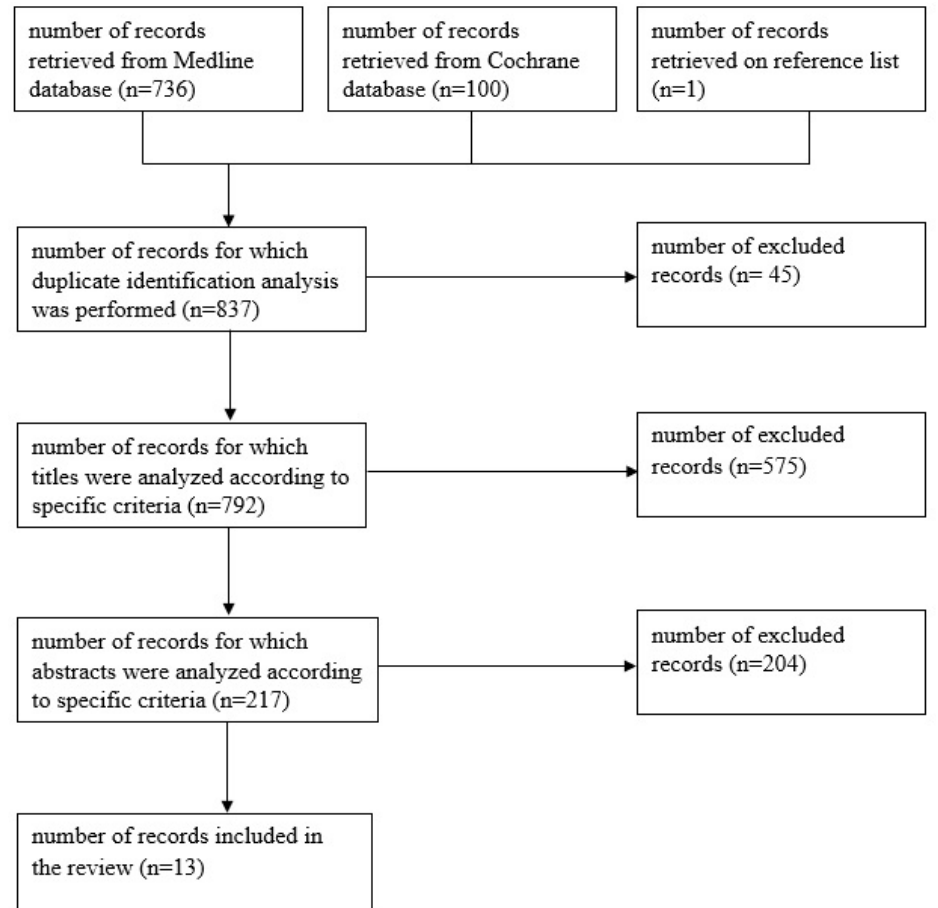
Figure 1. Figure describing the course of successive stages of including publications in the analysis.